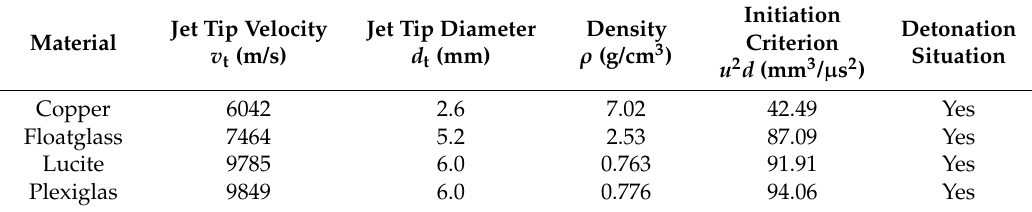
Table 8. The calculation results of the u - d initiation